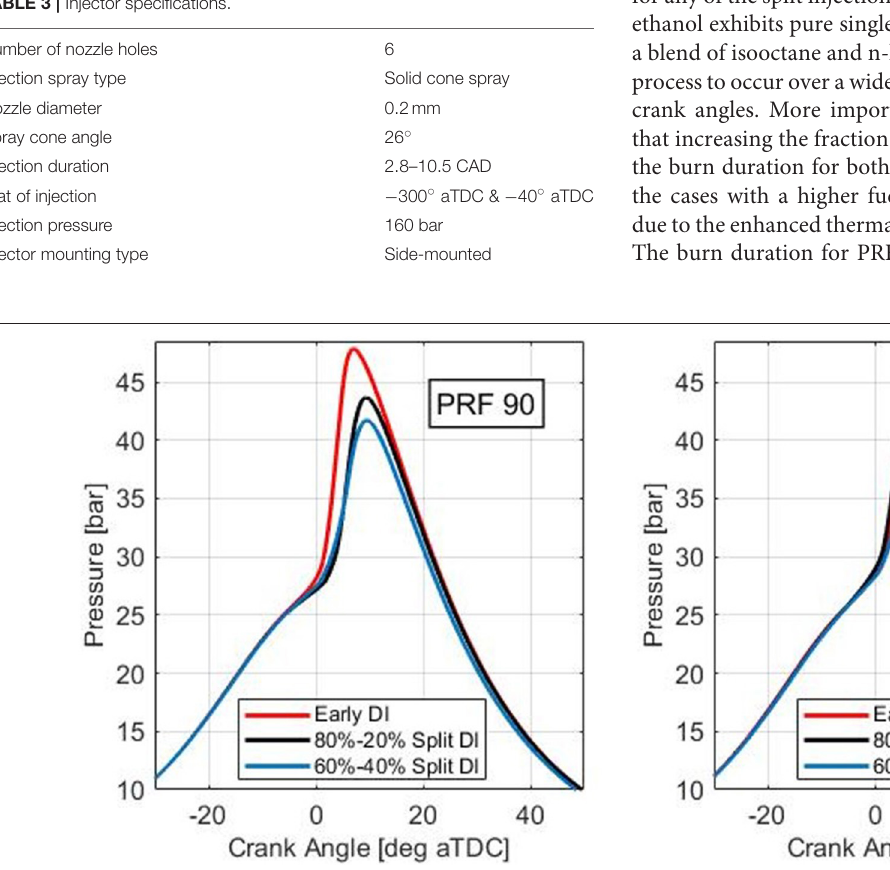
FIGURE 3 | Effect of fuel injection split fraction on the cylinder pressure of LTC for PRF90 and ethanol. Increasing the fuel fraction in the second injection (late injection) decreases the peak pressure.